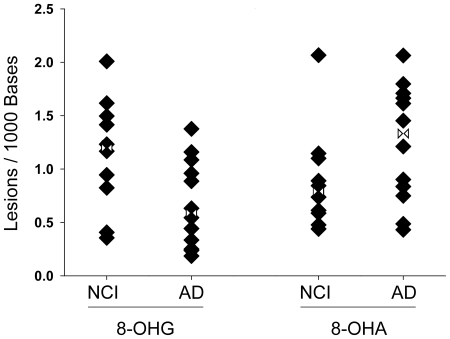
8-OHG and 8-OHA change in opposite directions in the late-stage AD brain.The 8-OHG adduct decreased (p = 0.046) in the disease state, whereas the 8-OHA adduct increased in AD brain (p = 0.038). Data are expressed as the number of oxidatively modified bases per 1000 bases of total RNA. The analysis included gender, age and PMI. Values were averaged over several disease-affected brain regions (c.f.
Table 1); no significant changes were seen in cerebellum. NCI: No Cognitive Impairment; AD: Alzheimer's disease. Rotated Hourglass: mean.